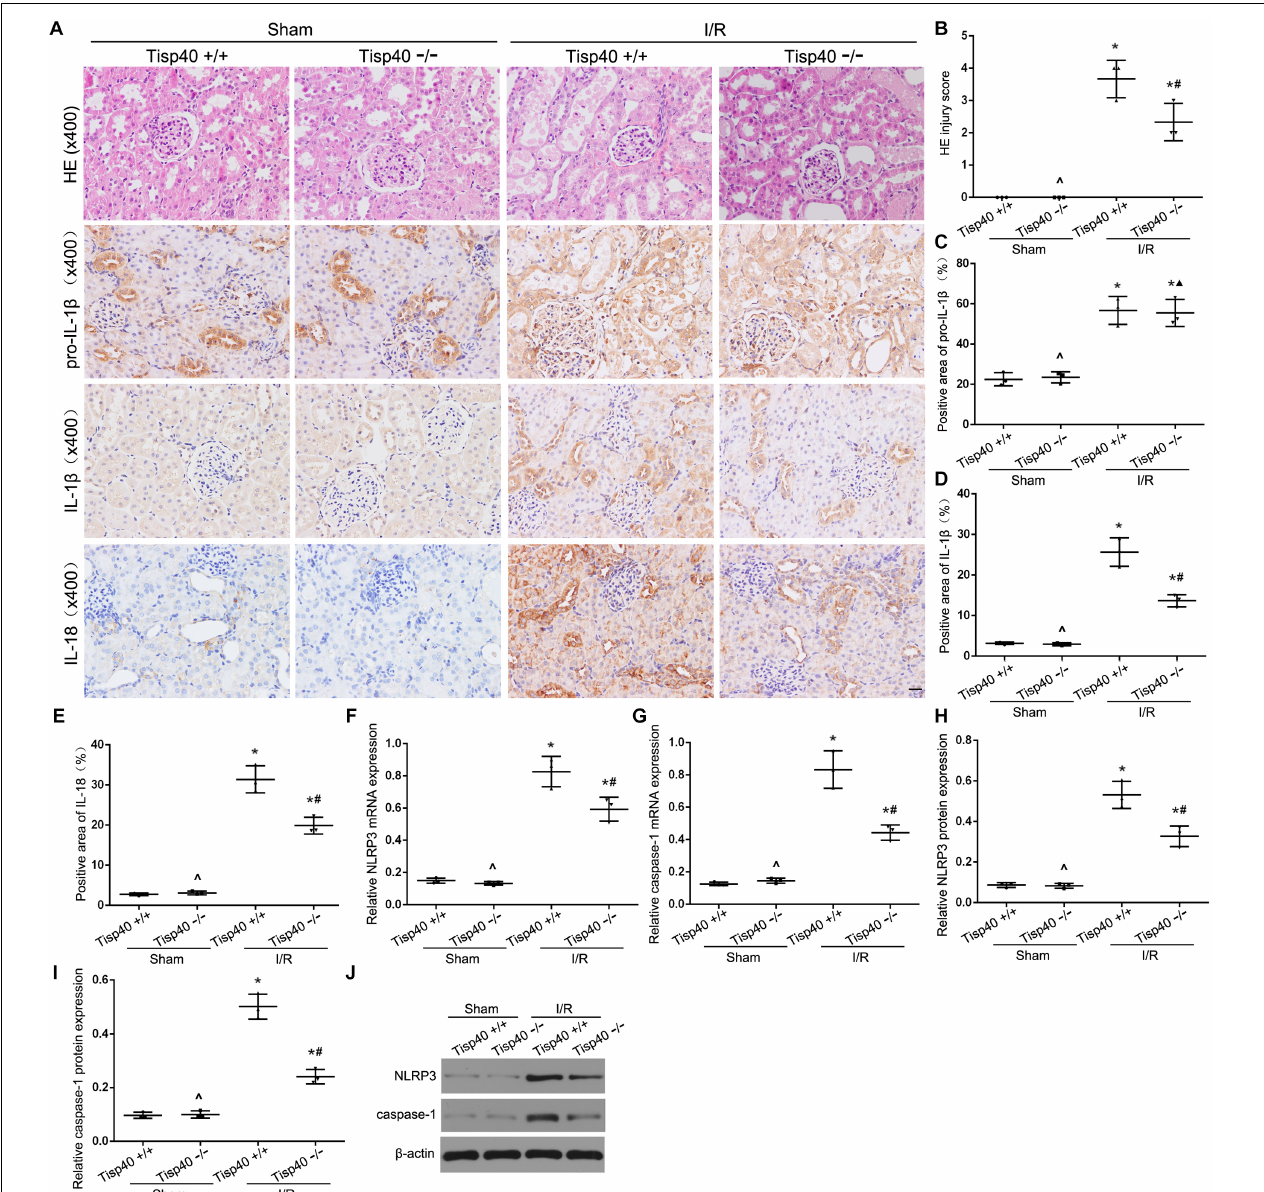
FIGURE 5 | Tisp40 knockout protects against NLRP3 inflammasome activation in I/R-induced kidney. (A) Representative photomicrographs of tubular cell injury in mouse kidney tissue sections with HE staining and representative photomicrographs of pro- IL-1 β , IL-1 β , and IL-18 expression in mouse kidney tissue sections by immunohistochemistry, 400 × , scale bar = 20 µ m. (B) Statistical quantification analysis showed the injury score of HE staining in the kidney tissues (C,D,E) Statistical analysis showed the positive area of pro- IL-1 β , IL-1 β , and IL-18 in the kidney tissues. (F–J) The expression of NLRP3 and caspase-1 were analyzed by qRT-PCR and Western blot. Data are expressed as the mean ± SD. n = 6 per group. * P < 0.05 vs. corresponding sham-operation groups (Sham). ∧ P > 0.05 vs. Tisp40 + / + in sham groups. # P < 0.05, (cid:78) P > 0.05 vs. the group of I/R-induced Tisp40 + / + mice. one-way